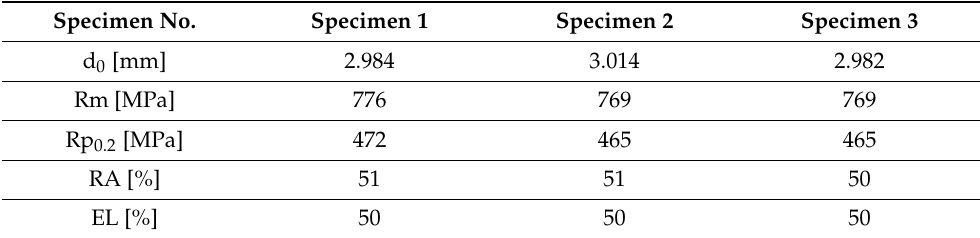
Table 3. Tensile test results of 3 mm gauge diameter specimens machined from 3.5 mm diameter printed.